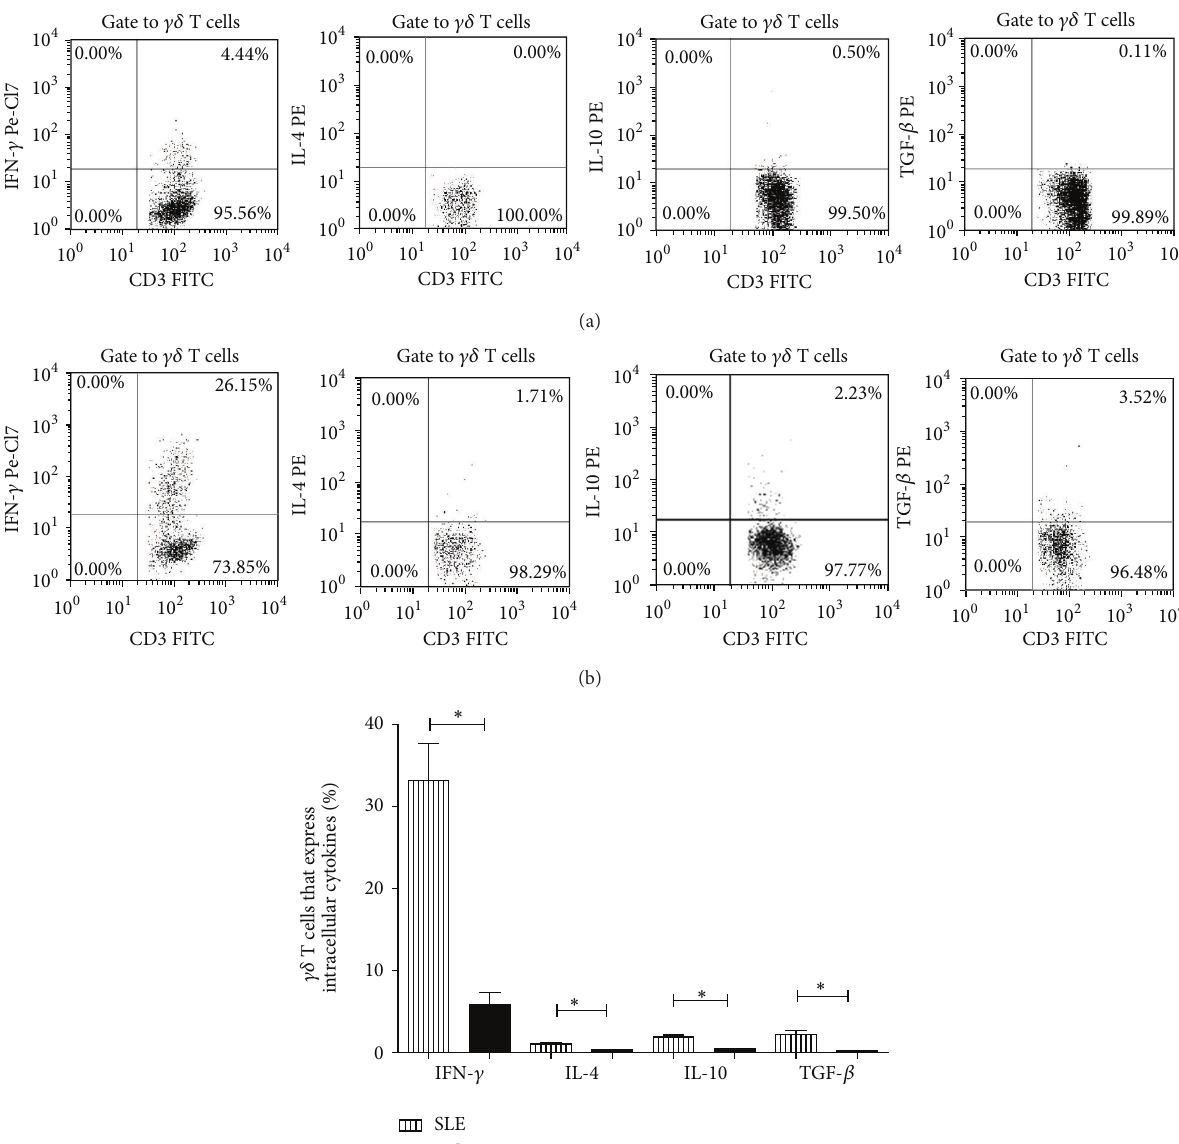
∗∗ ∗ ∗ (c) Figure 5: Expression of intracellular cytokines in peripheral 𝛾𝛿 T cells from SLE patients ( 𝑛 = 20 , ∗ 𝑃 < 0.01 ). (a) Representative flow cytometric plots of 𝛾𝛿 T cells that express various intracellular cytokines from one healthy control and SLE patient, respectively. The data of IL-17 + and Foxp3 + 𝛾𝛿 T cells, which were nearly undetectable, were not shown. (b) Comparison of the percentages of 𝛾𝛿 T cells expressing IFN- 𝛾 , IL-4, IL-10, or TGF- 𝛽 in SLE patients and healthy